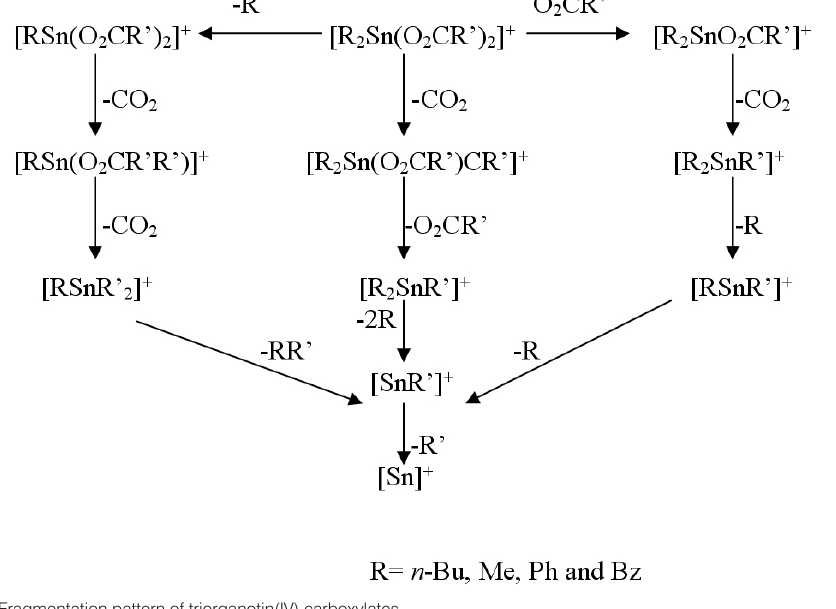
Scheme 2. Fragmentation pattern of triorganotin(IV)